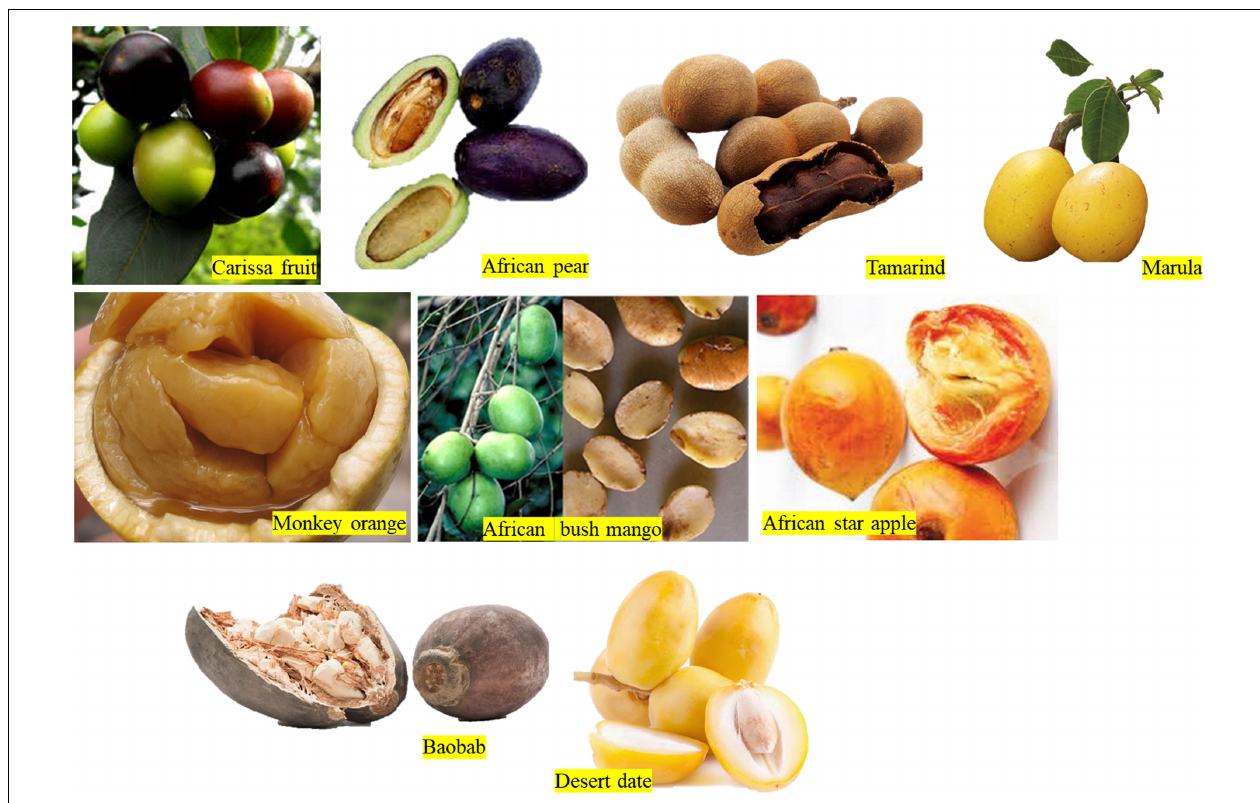
FIGURE 3 | African native fruits (https://www.google.com/search?q=fruits+in+africa&sxsrf=AOaemvID5L7IffILh1Ps_tXHgaANzaTqpA: